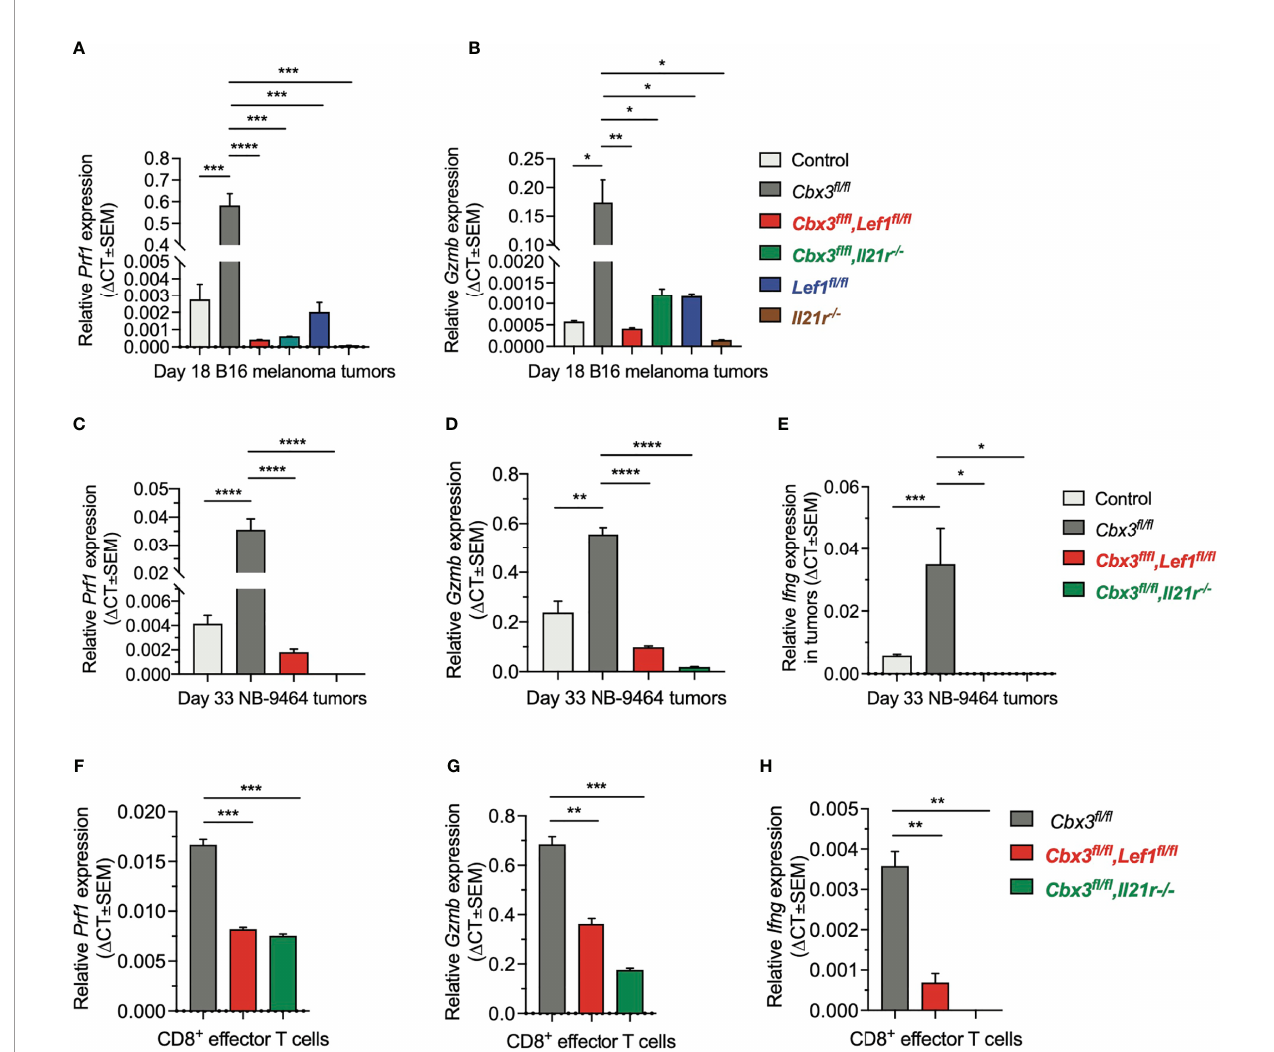
FIGURE 7 | LEF-1 and IL-21R are required for CD8 + T cells to maintain their effector capacity. (A, B) Prf 1 and Gzmb relative expression in B16 melanoma tumors was determined by RT-qPCR; Graphpad unpaired student t-test: *p ≤ 0.05, **p ≤ 0.01, ***p ≤ 0.001, ****p ≤ 0.0001; n = 3 tumors; representative of 3 experiments. (C – E) Prf1 , Gzmb and Ifng relative expression in NBL tumors was determined by RT-qPCR; Graphpad unpaired student t-test: *p ≤ 0.05, **p ≤ 0.01, ***p ≤ 0.001, ****p ≤ 0.0001; n = 3 tumors; representative of 3 experiments. (F – H) Prf1 , Gzmb and Ifng relative expression in day 5 in vitro -activated/differentiated CD8 + T cells from Cbx3 /HP1 g -de fi cient and compound mutant mice was quanti fi ed by RT-qPCR; Graphpad unpaired student t-test: **p ≤ 0.01, ***p ≤ 0.001; representative of 3